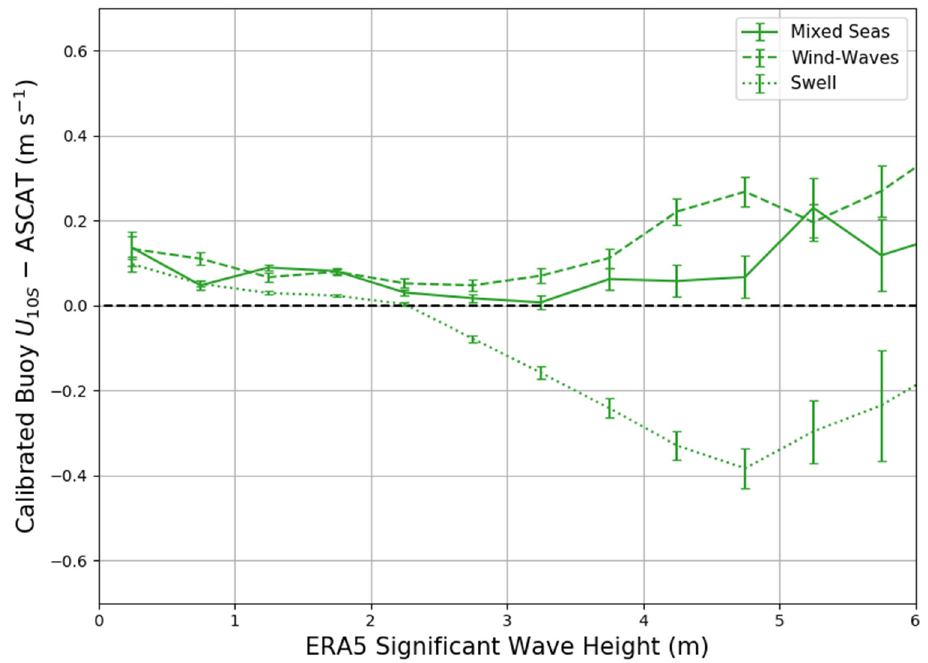
Figure 8. Bin averages of calibrated wind speed residuals (calibrated buoy U 10 S –ASCAT) compared with ERA5 significant wave height ranges for wind seas (dashed lines), mixed seas (solid lines), and swell dominant seas (dotted lines). Error bars represent ±1 standard error.